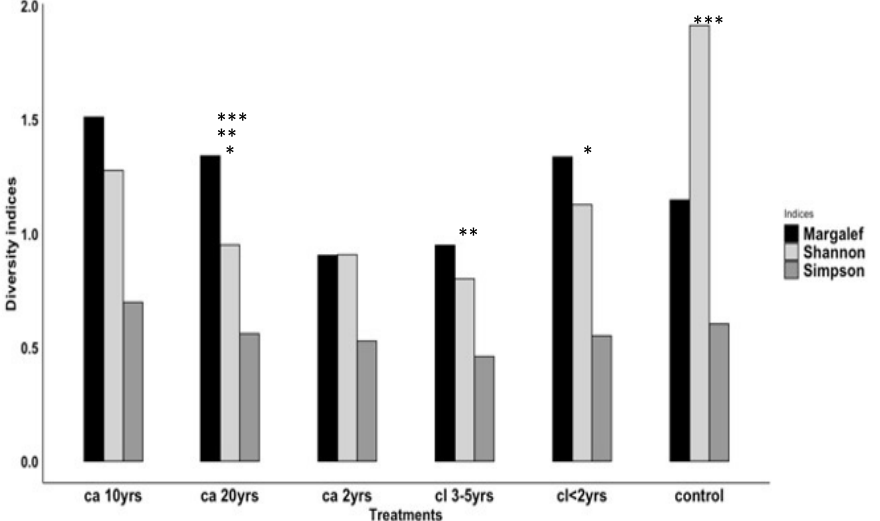
Figure 6. Showing the mean of the diversity indices for captured animals in six different treatments inside the reserve. Asterisks show the treatment pairs that are significantly different from each other.